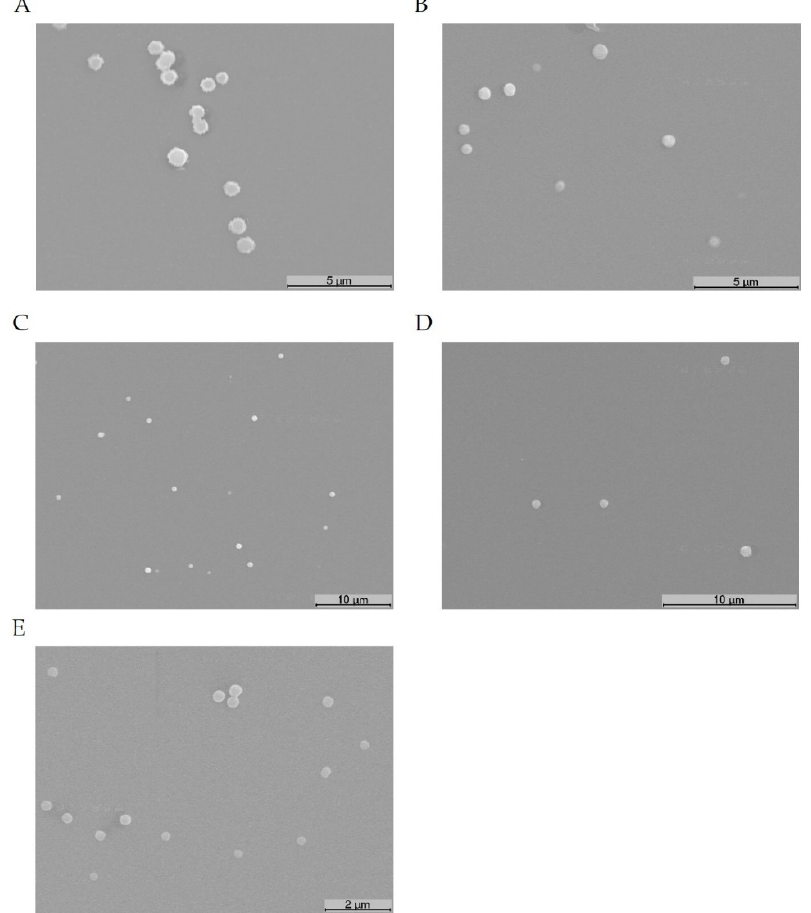
Figure 3. Scanning electron micrographs of PAMAM G4-PTX/pDNA/PEI complexes formulated at N/P ratios of 5:2:1 ( A ), 10:2:1 ( B ), 20:2:1 ( C ), 50:2:1 ( D ) and 100:2:1 ( E ).